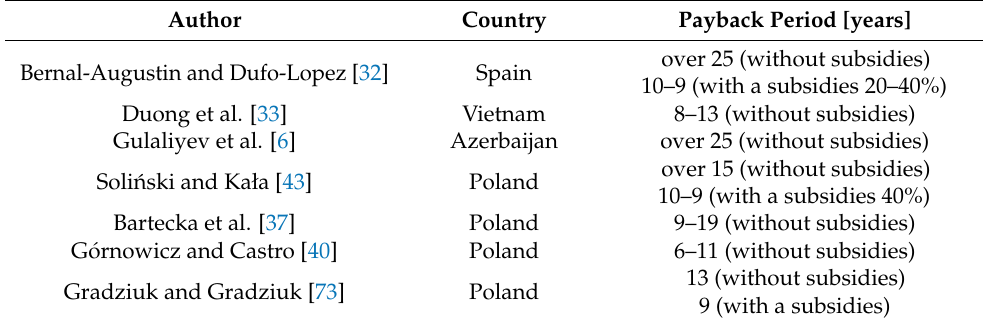
Table 6. The comparison of Payback